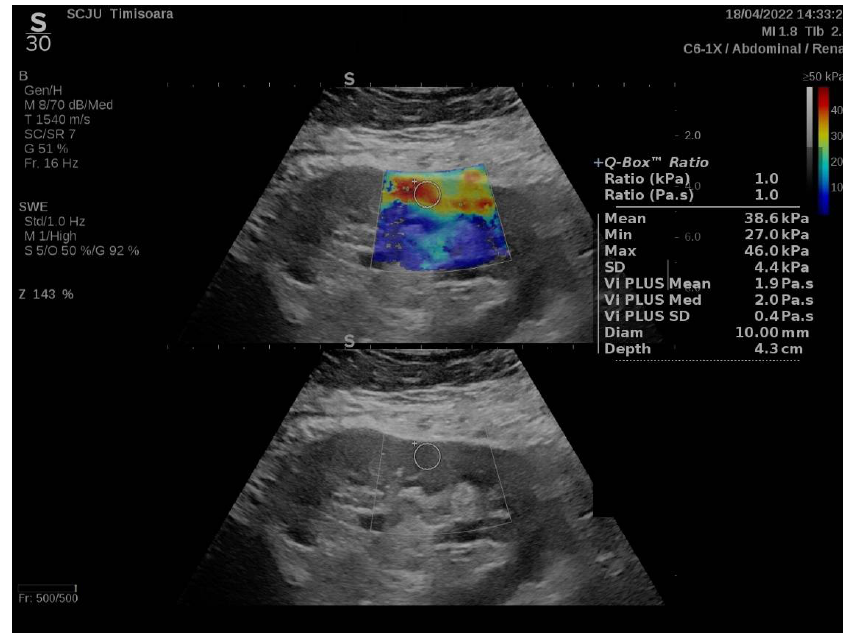
Figure 1. A healthy participant’s kidney viscoelasticity map.